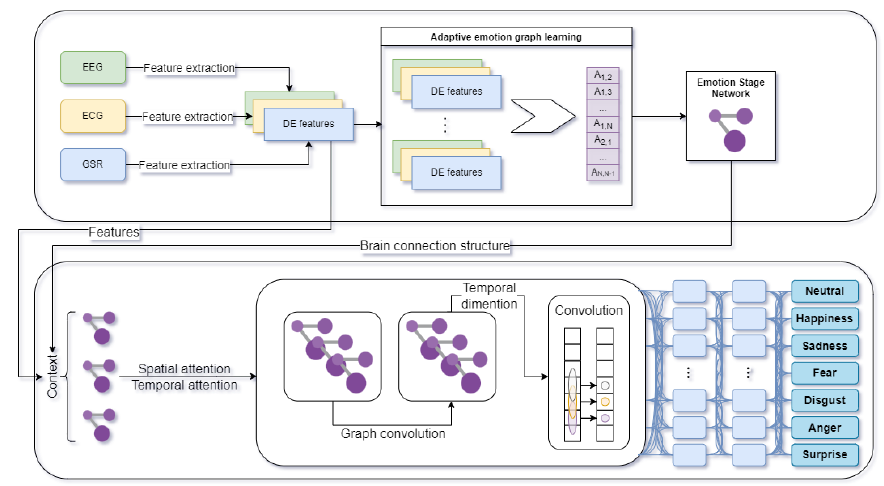
Figure 2. Overall architecture of GraphEmotionNet (own elaboration based on GraphSleepNet [3]).